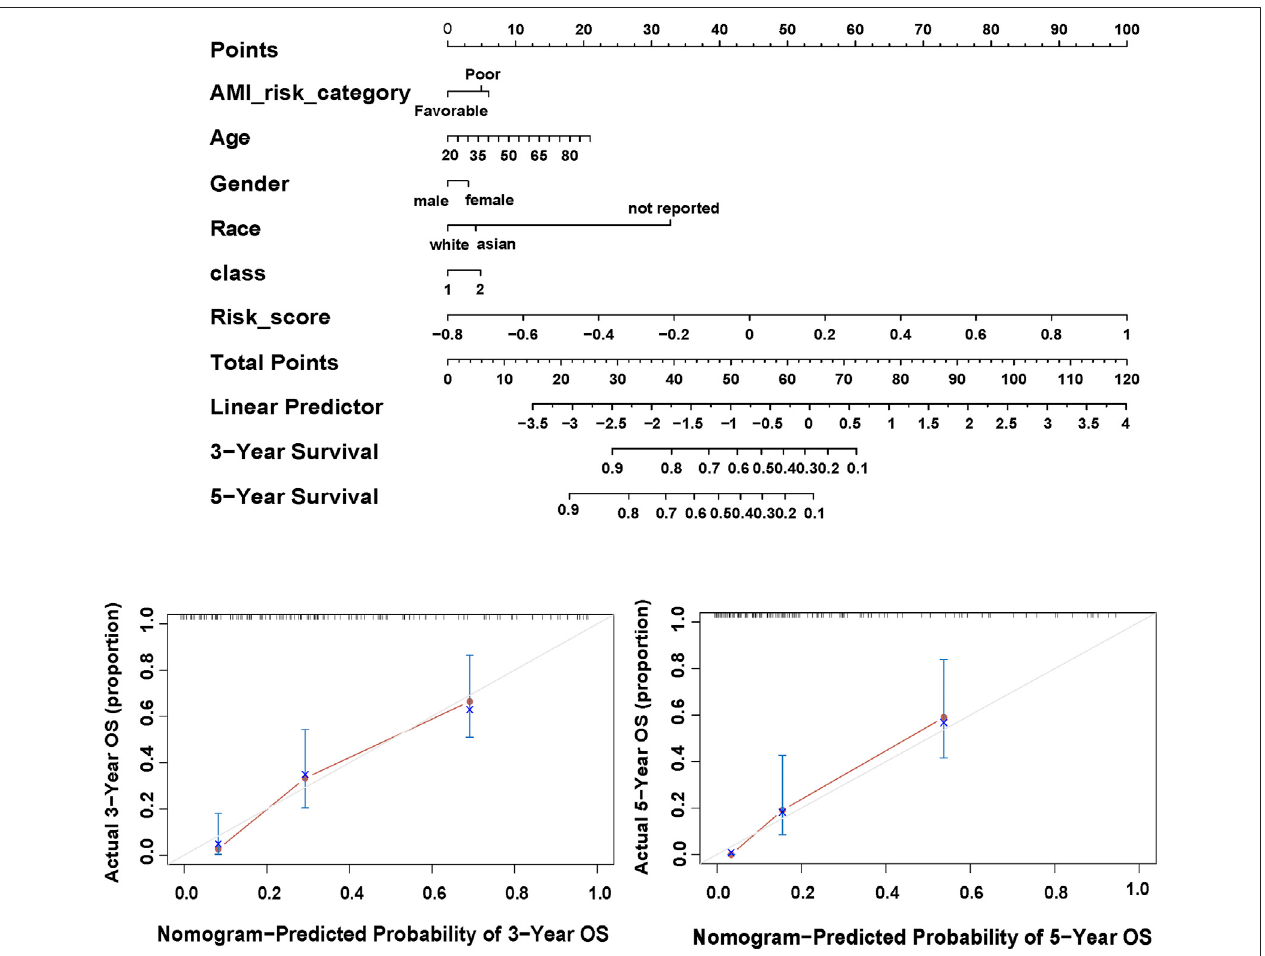
FIGURE 7 | Nomogram of the TCGA-LAML. (A) Nomogram predicting 3- and 5-year OS for the AML patients. (B,C) Calibration curve for the nomogram.